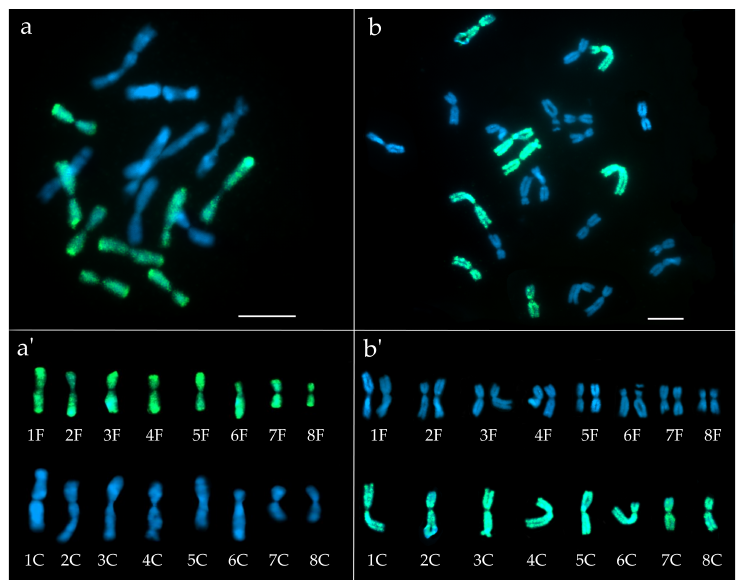
Figure 1. GISH on mitotic metaphase chromosomes of F 1 interspecific hybrids between A. cepa and A. fistulosum : ( a ) F 1 diploid hybrid contains 8 chromosomes of A. cepa and 8 chromosomes of A. fistulosum ; ( b ) F 1 triploid hybrid contains 8 chromosomes of A. cepa and 16 chromosomes of A. fistulosum ; ( a (cid:48) , b (cid:48) ) karyotypes of the F 1 diploid and F 1 triploid hybrids, respectively. Bars represent 10 µ m.